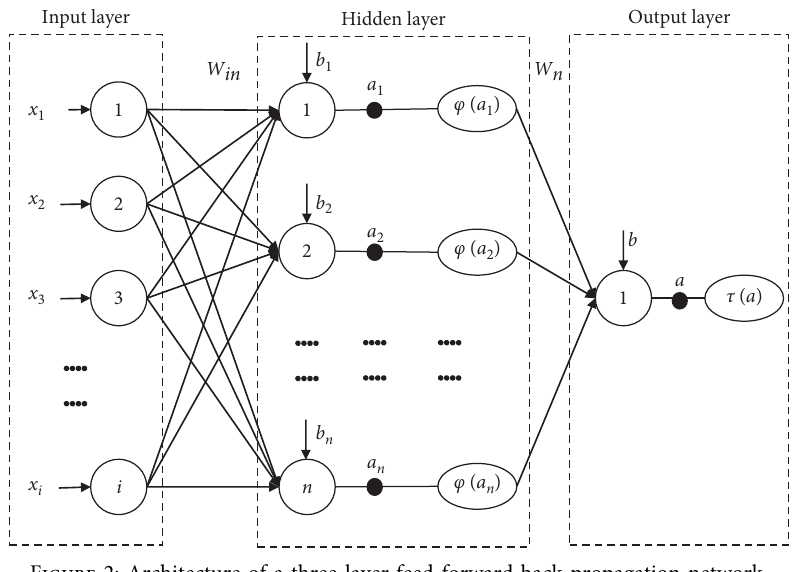
Figure 2: Architecture of a three-layer feed-forward back-propagation network.